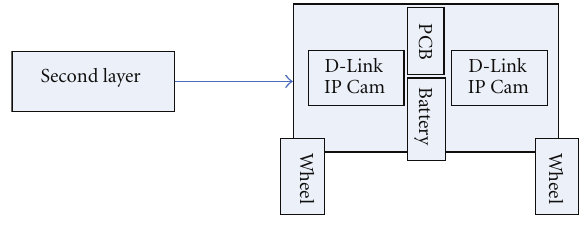
Figure 9: The sketch of second layer.